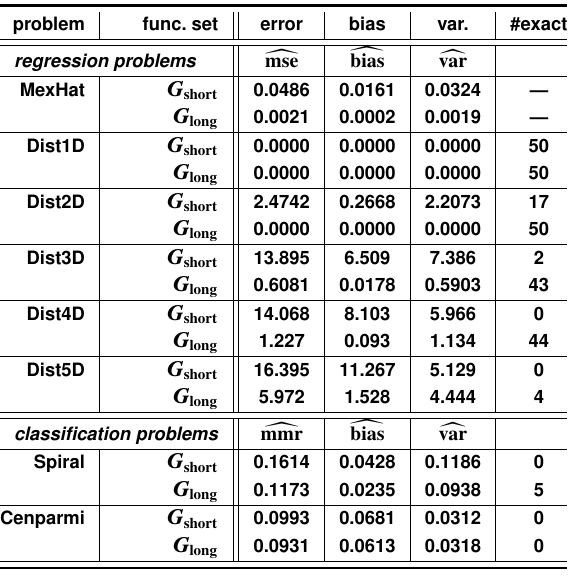
Table 4. Integrated error and bias-variance decomposition on the target benchmarks. “Exact” solutions, for the regression problems DistND, refer to individuals whose symbolic expression reduces exactly to the target function f (cid:3) (impossible for MexHat, in the absence of Euler’s number e ) and, for the classification problems Spiral and Cenparmi, to those achieving a zero